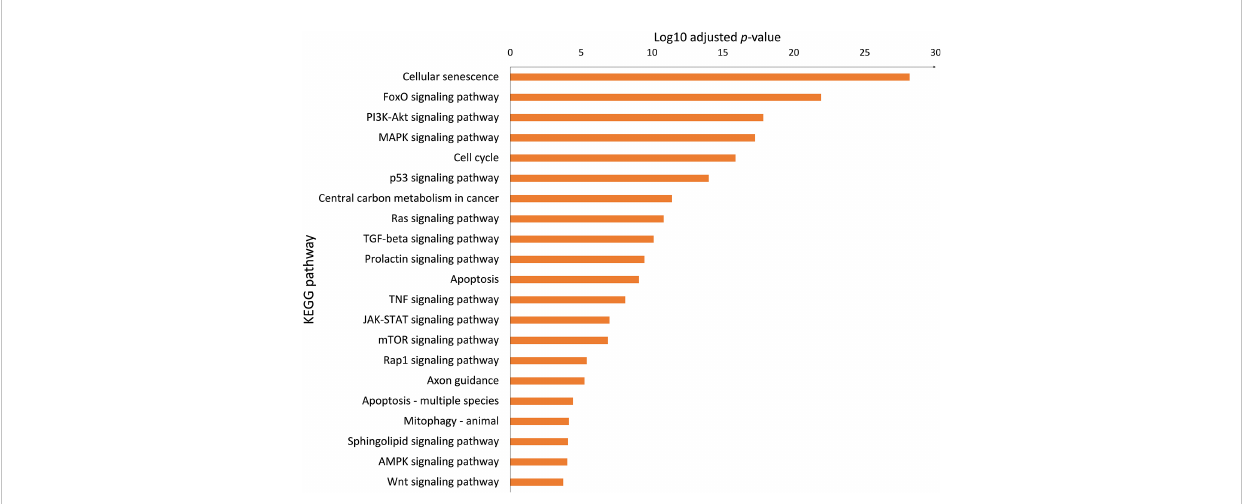
FIGURE 5 Biological pathways associated with cell proliferation and apoptosis. The Bar chart showed signi fi cant KEGG pathways involved in cell proliferation and apoptosis enriched the upregulated microRNAs (adjusted P-value < 0.05, selected from 122